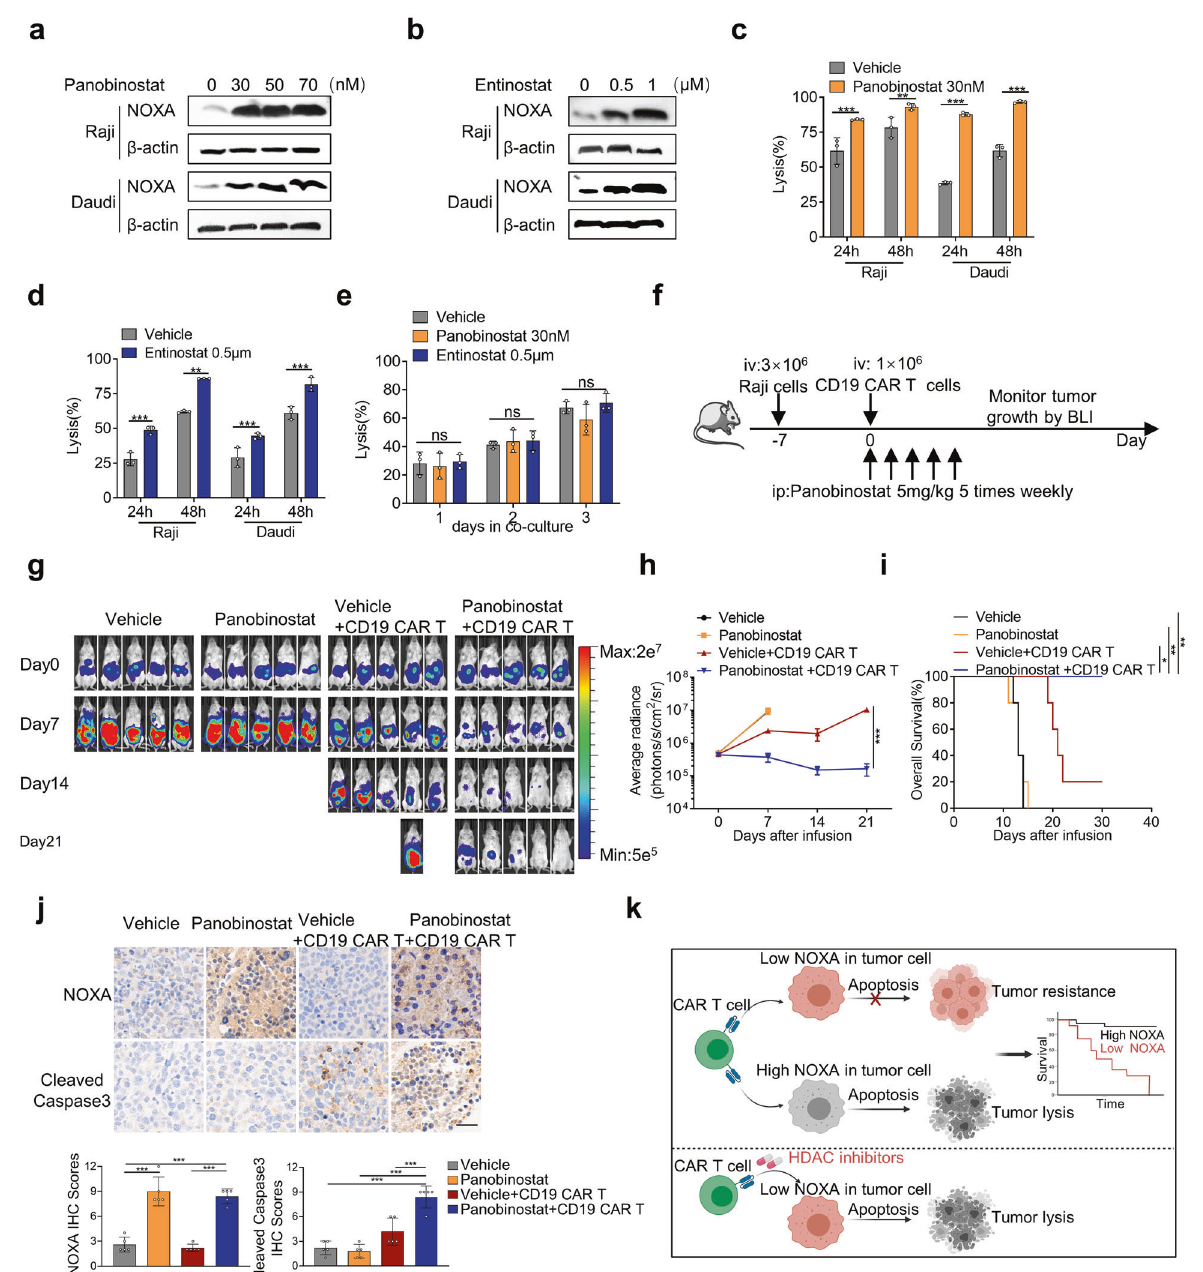
Fig. 6 Histone deacetylase inhibitors could enhance tumor cell vulnerability to CAR T cells. a , b Western blot analysis of Raji cells and Daudi cells treated with panobinostat ( a ) or entinostat ( b ) for 24 h. c , d Cytotoxic analysis of Raji cells and Daudi cells pretreated with 30 nM panobinostat ( c ) or 0.5 μ M entinostat ( d ) for 24 h and then cocultured with CD19 CAR T cells over time. e Cytotoxic analysis of NOXA KO Nalm6 cells pretreated with 30 nM panobinostat or 0.5 μ M entinostat for 24 h and then cocultured with CD19 CAR T cells over time. Values in ( a – e ) were shown as the mean ± SD of triplicates. f Experimental timeline comparing the antitumor ability of vehicle alone, panobinostat alone, the combination of vehicle and CD19 CAR T cells, and combination of panobinostat and CD19 CAR T cells in mice bearing Raji-luc xenograft tumors ( n = 5 mice per group). g Raji tumor progression as evaluated by bioluminescence imaging. h Mouse tumor burden (average radiance). The indicated P value was determined by two-way ANOVA test. i Survival analyses of mice treated with vehicle alone, panobinostat alone, the combination of vehicle and CD19 CAR T cells, and combination of panobinostat and CD19 CAR T cells. Log-rank tests were used to analyze the signi fi cance between four groups. j Representative images of IHC staining for NOXA and cleaved caspase3 from Raji tumor xenografts treated with the indicated treatments. Magni fi cation: ×40, Scale bars: 20 μ m. Quanti fi cation of IHC staining using IHC scores was represented as mean ± SD of fi ve mice per group. P values were calculated with the two-tailed Student ’ s t test. k Schematic drawing summarizing our fi ndings. Values are shown as the mean ± SD. ns: not signi fi cant ( P > 0.05); * P < 0.05, ** P < 0.01, and *** P <